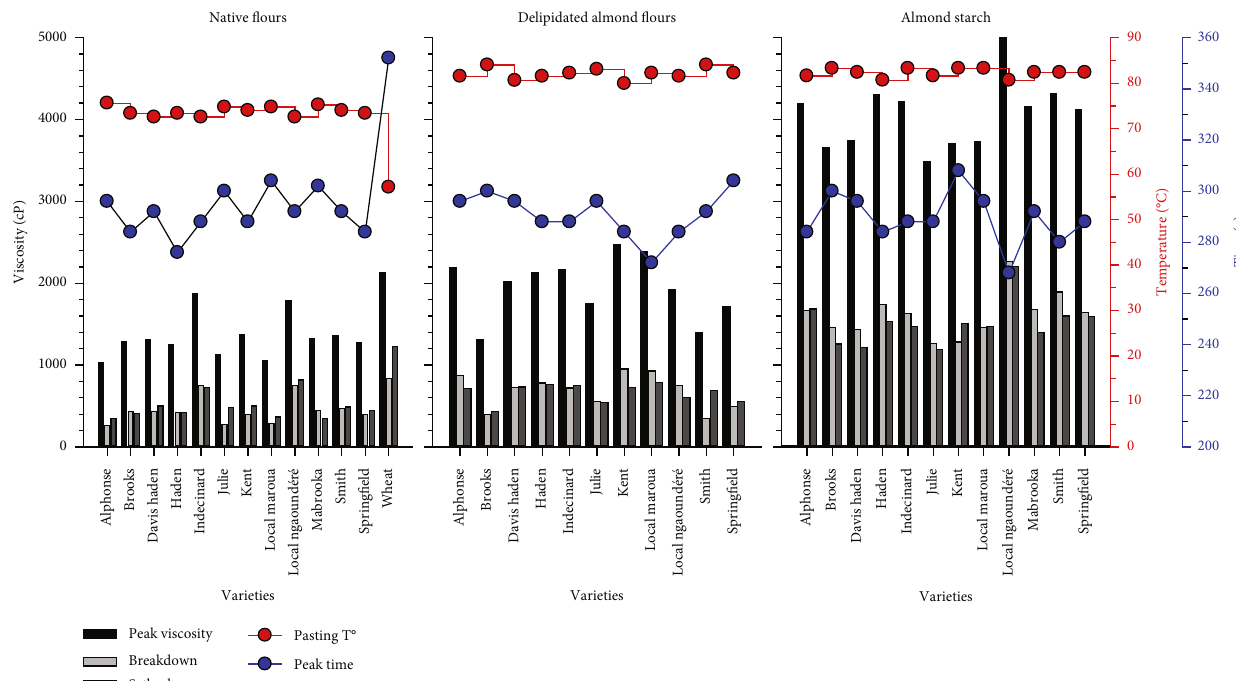
Figure 1: Pasting indicators of mango almonds fl ours (native and delipidated) and starch from di ff erent mango varieties and wheat fl